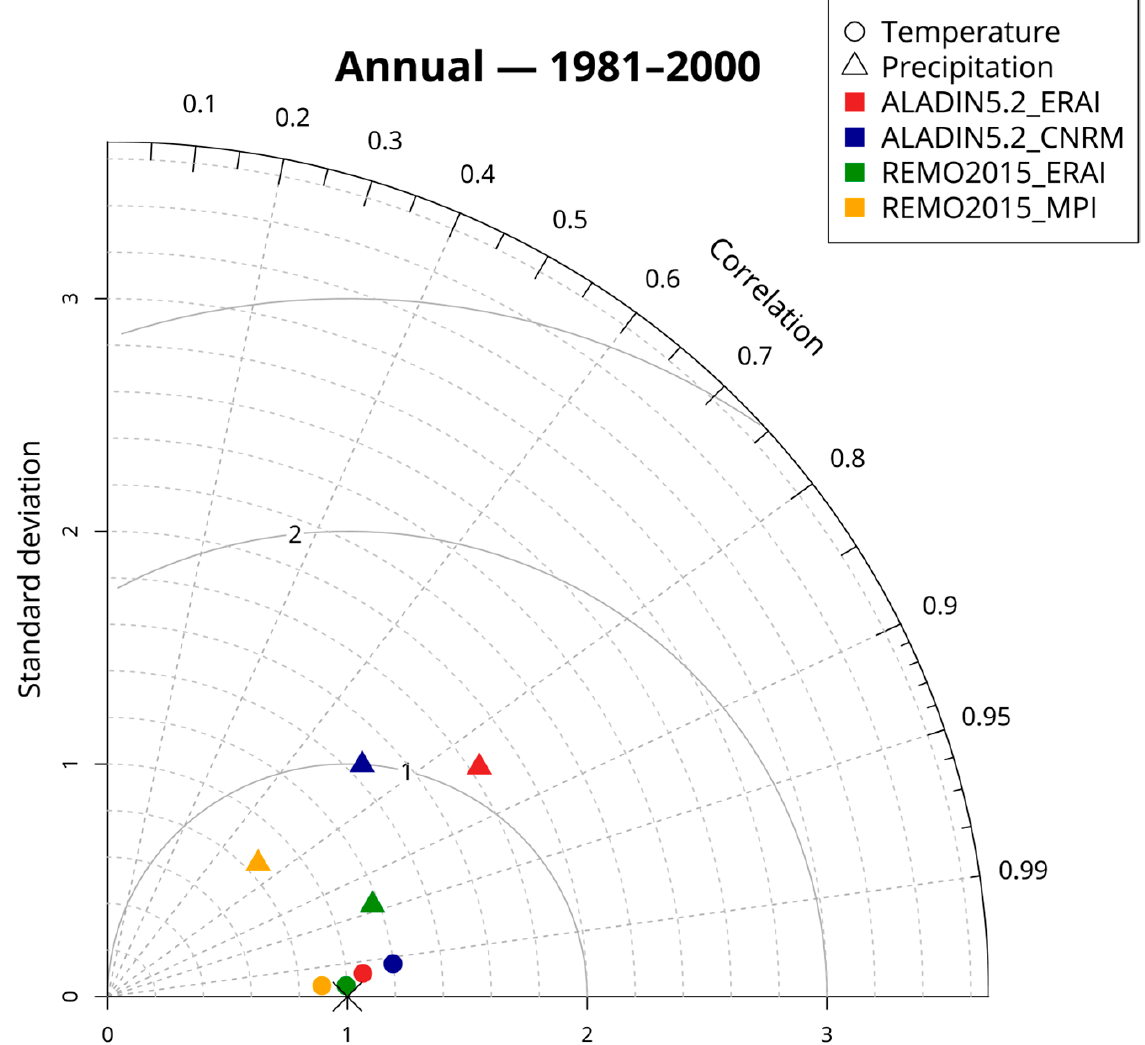
Figure 3. Taylor diagram for monthly mean temperature (circles) and precipitation (triangles) of four RCM simulations (colors) over Hungary for 1981–2000. Reference: CarpatClim-HU dataset (represented by an X).